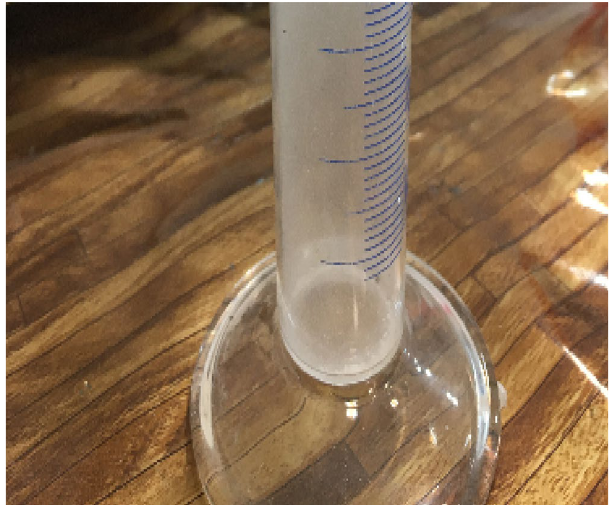
Figure 3. Residual raw materials, exited from the reactor by SC-CO 2 after depressurizing.